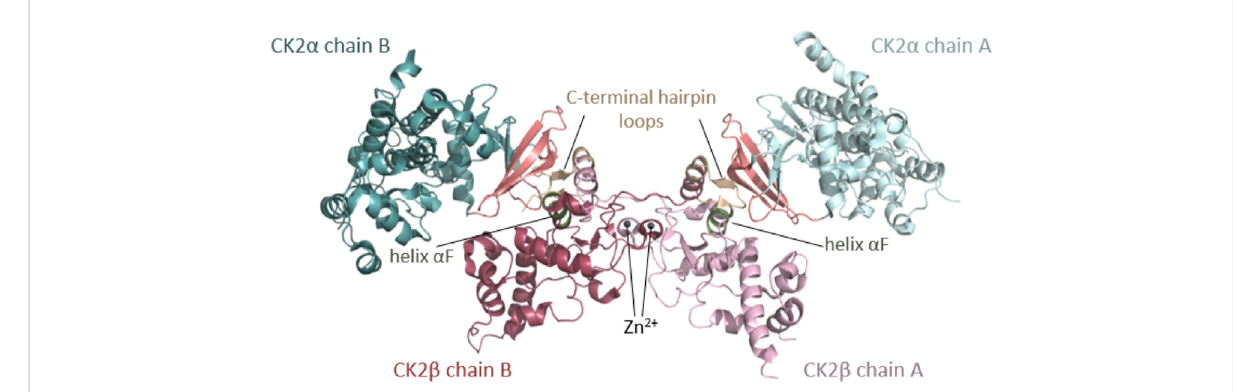
FIGURE 1 ArchitectureoftheheterotetramericCK2holoenzyme.CK2 α hastwolobes:aN-terminaldomainbasedonacentral5-stranded β -sheetandan α -helical C-terminal domain. CK2 β has two domains: an α -helical domain and a zinc fi nger domain that serves as a dimerization interface. CK2 β forms dimers via the zinc fi nger, hydrophobic core residues, and the crossover of the C-terminal tails over the other CK2 β subunit. Due to the crossover of the C-terminal tails of the CK2 β dimer, both CK2 β chains are involved in the interaction with both CK2 α chains. The contact of the CK2 β dimer to the two spatially separated CK2 α subunits is mediated via the C-terminal hairpin loop of one CK2 β chain ( α / β tail contact, coloured wheat) and the area around helix α F of the other CK2 β chain ( α / β body contact, coloured dark green). The subunit interaction interface of CK2 α is located at the outer surface of the β -sheet of the N-terminal lobe (coloured salmon) (Nie fi nd et al., 2001). The Figure was drawn with PyMOL (Schrödinger, 2013) using the CK2 holoenzyme structure (PDB_ID: 4DGL (Lolli et al., 2012)). Detailed fi gures of functional domains in the structural